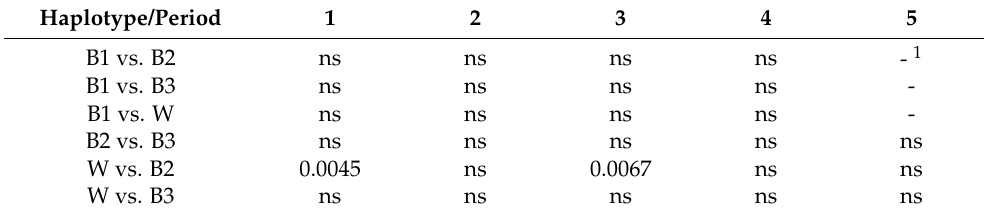
Table A4. p -values of the comparison of body weight of the different haplotypes per period.